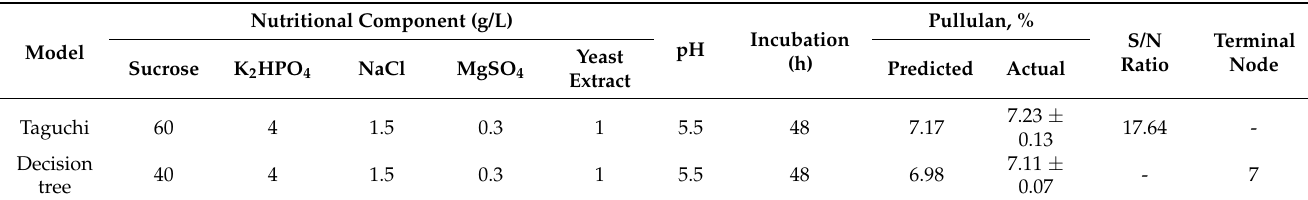
Table 4. The predicted fermentation conditions were estimated based on the Taguchi and DT models as well as the predicted and actual values of pullulan biosynthesis by A. pullulans